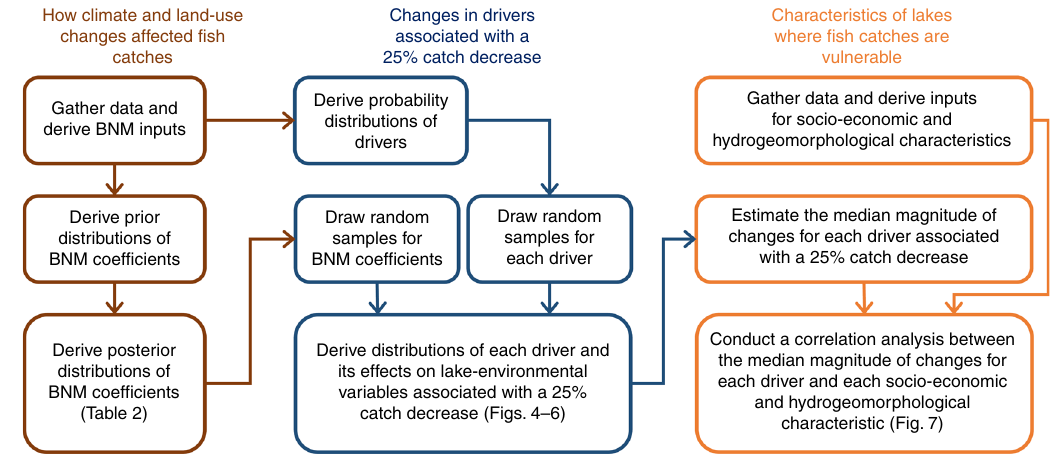
Fig. 3 Summary fl owchart for the procedures of three analyses conducted in this study. BNM Bayesian networks